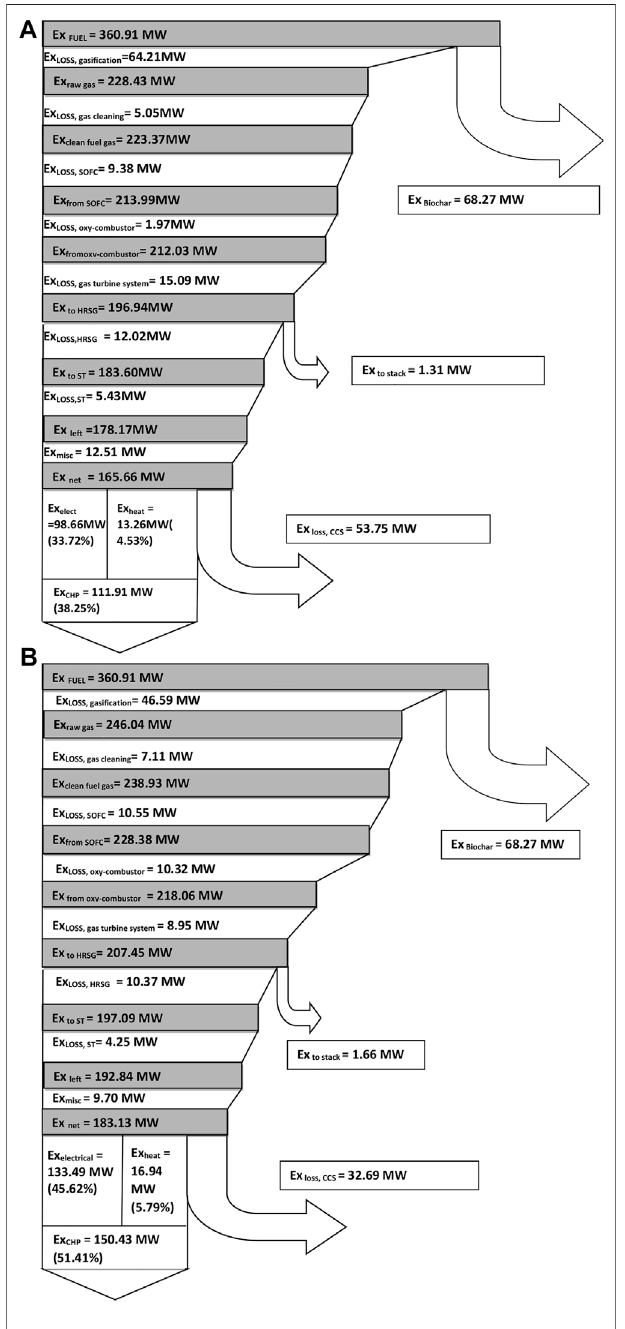
FIGURE 5 | (A) Exergy fl ow diagram for the air gasi fi cation case with 10% biochar co-production. (B) Exergy fl ow diagram for the steam-oxygen gasi fi cation case with 10% biochar co-production. FIGURE 6 | (A) Effect of biochar co-production on the gasi